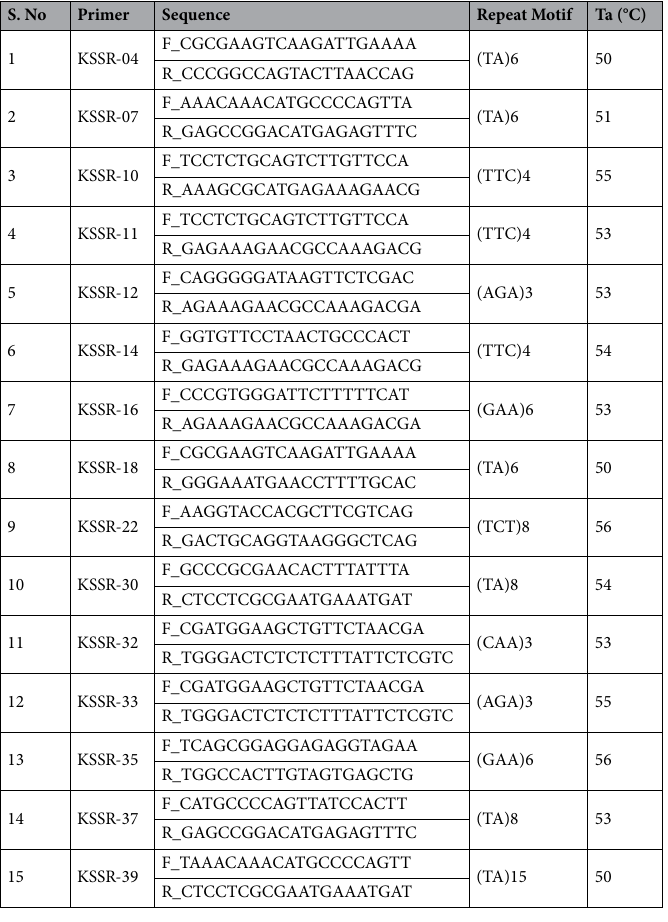
PAGE (Poly Acrylamide Gel Electrophoresis) gel and were visualised using silver staining method along with size estimation of amplified product against 50 bp ladder (ThermoFisher). SSR data scoring, genetic diversity and population structure prediction. Stable and highly poly- morphic fifteen SSR markers (KSSR) were utilised for genotyping of 48 individuals from 10 wild natural popula- tions belonging to three cold desert regions (Kullu, Kinnaur and Lahaul & Spiti) of Himachal Pradesh (Table 7). Presence (1) and absence (0) of bands of a particular size (molecular weight) in the genotyping profiles of all the individuals were scored manually in the binary format. To establish the genetic relationship among col- lected individuals, each band on the genotyping profile was considered as loci or marker. Scored data for all individuals was utilised for Nei’s gene diversity ( h ), shannon’s information index ( I ), effective number of alleles